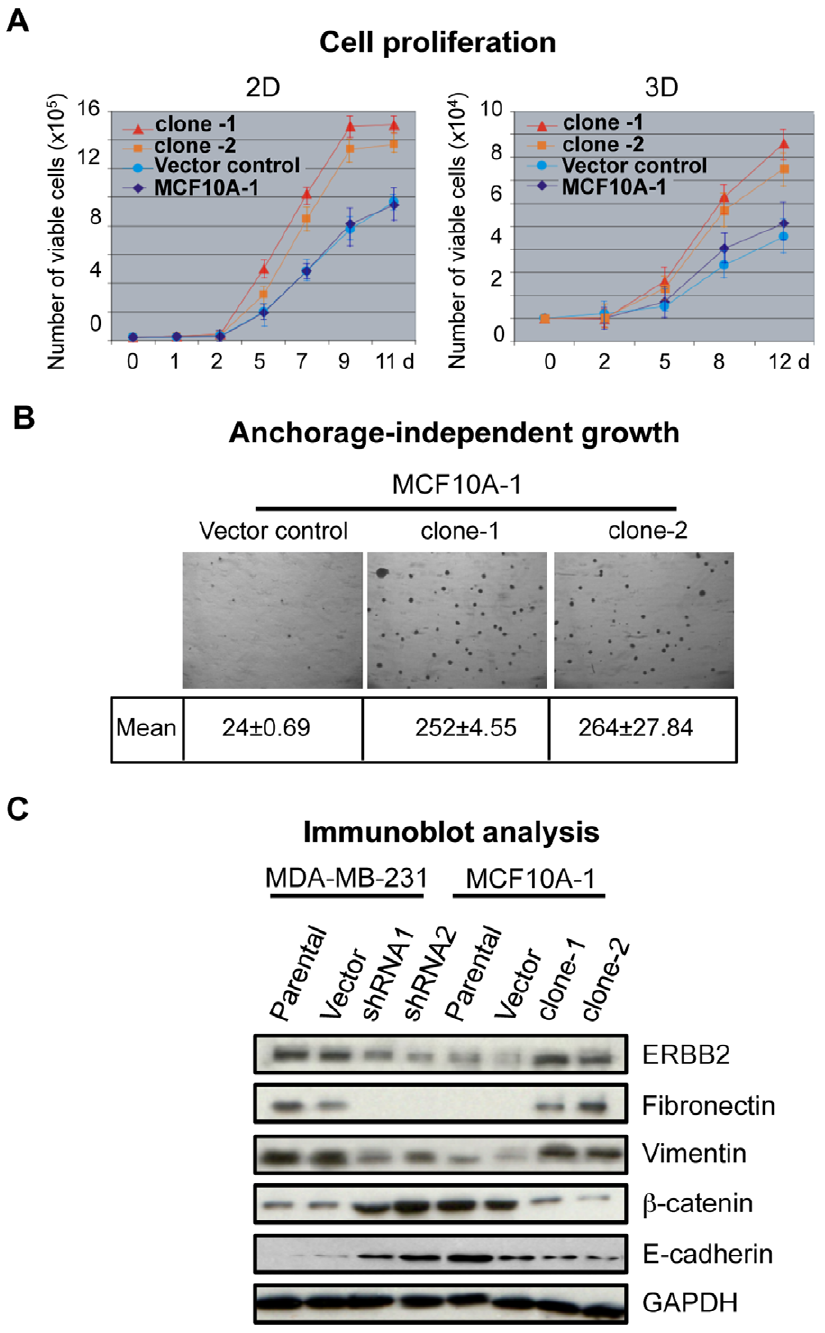
Figure 2. SATB1 overexpression induces EMT in MCF10A-1 cells. A ) Cell proliferation assay to compare the growth over time (days, d) of the parental MCF10A-1 and vector control cells with single-cell-derived SATB1-overexpressing MCF10A-1 clones clone-1 and clone-2 on plastic dishes (2D) or on Matrigel (3D). Error bars indicate 6 s.e.m. from three independent experiments. B ) Representative photographs of soft agar colonies formed by control and SATB1 overexpressing (clone-1 and clone-2) MCF10A-1 cells after 25 days of culture. The mean colony counts from three replicates are shown. C ) Immunoblot analyses for the expression of mesenchymal markers (fibronectin and vimentin), epithelial markers (E-cadherin and ß-catenin) as well as SATB1 target ERBB2 in MDA-MB-231 (parental, control and SATB1-depleted by shRNA1 or shRNA2) and MCF10A-1 (parental, control, clone-1 and clone-2). Cell lysates were prepared from cells cultured on plastic dishes (2D). GAPDH was used as a loading control. doi:10.1371/journal.pone.0051786.g002 aggressive phenotype of clone-1-TUM is reversible by reducing 30% SATB1 expression, produced far fewer metastases. Of 6 mice, all had 25 or fewer nodules, with an average of 9 nodules SATB1 levels. per lung (Fig. 3F, upper panel). These data indicate that the We observed varying degrees of lung metastases by clone-1- TUM cells, which may be attributable to different SATB1